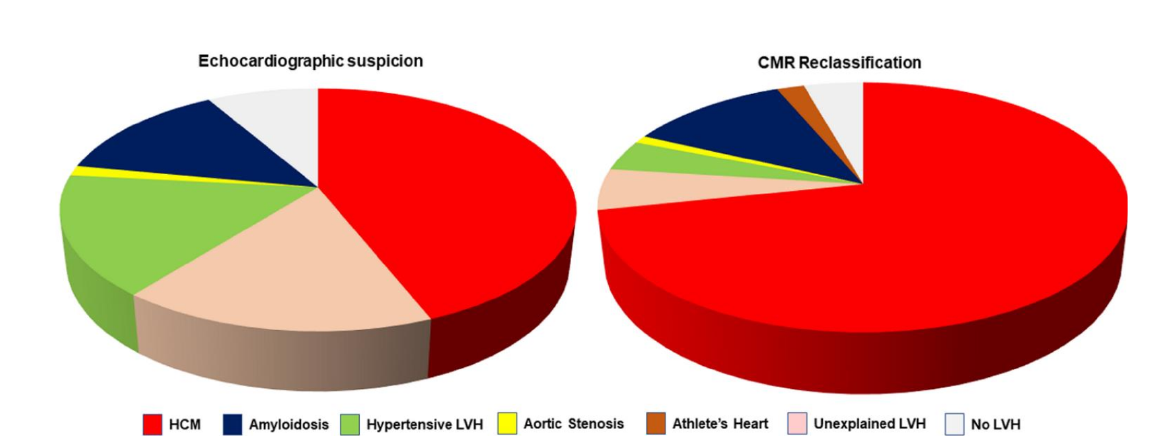
Figure 1. The left graph shows the distribution of initial diagnostic suspicion by transthoracic echocardiography (TTE). The right graph shows the reclassification of diagnosis by cardiac magnetic resonance (CMR). As evident by the comparison of the two graphs, CMR allowed a significant decrease in cases with undetermined left ventricular hypertrophy (LVH), as well a decrease in the percentage of hypertensive LVH. HCM, hypertrophic